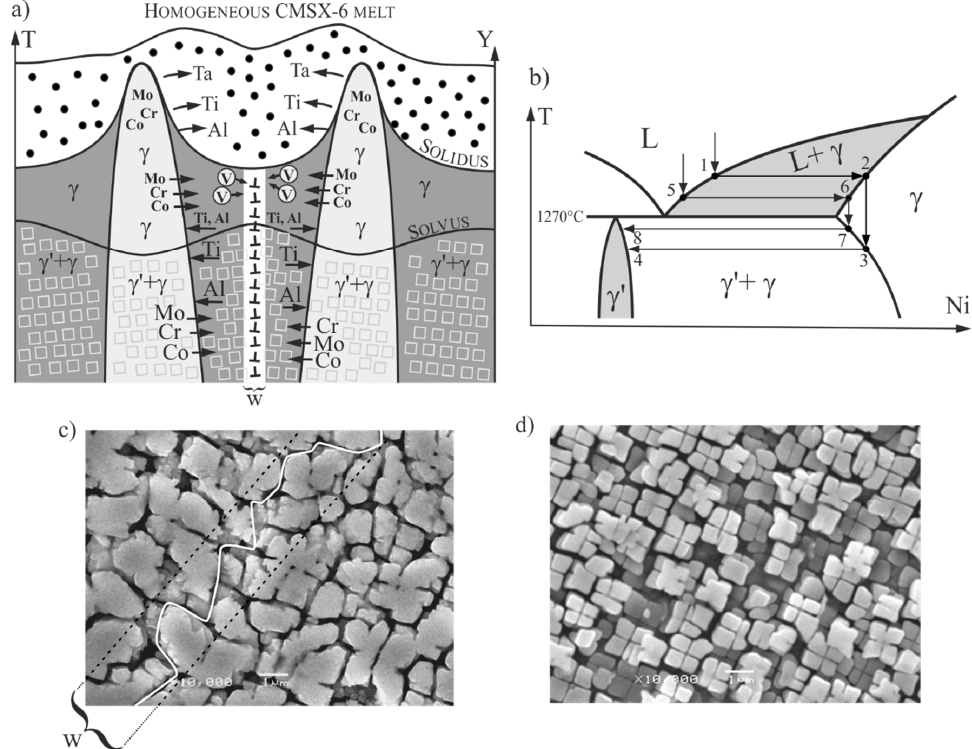
Figure 7. ( a ) Scheme of alloying elements’ distribution in the LAB area; ( b ) fragment of Ni–Al phase diagram; ( c ) example of γ / γ (cid:48) structure typical for areas 1, 2, and 3 of the PALS measurements in diagram; (c) example of γ / γ ′ structure typical for areas 1, 2, and 3 of the PALS measurements in inter- inter-dendritic regions and ( d ) in dendritic regions. Dotted area—diffusion area of liquid, W—the dendritic regions and (d) in dendritic regions. Dotted area—diffusion area of liquid, W—the hypothetical LAB area, V—vacancies. hypothetical LAB area,